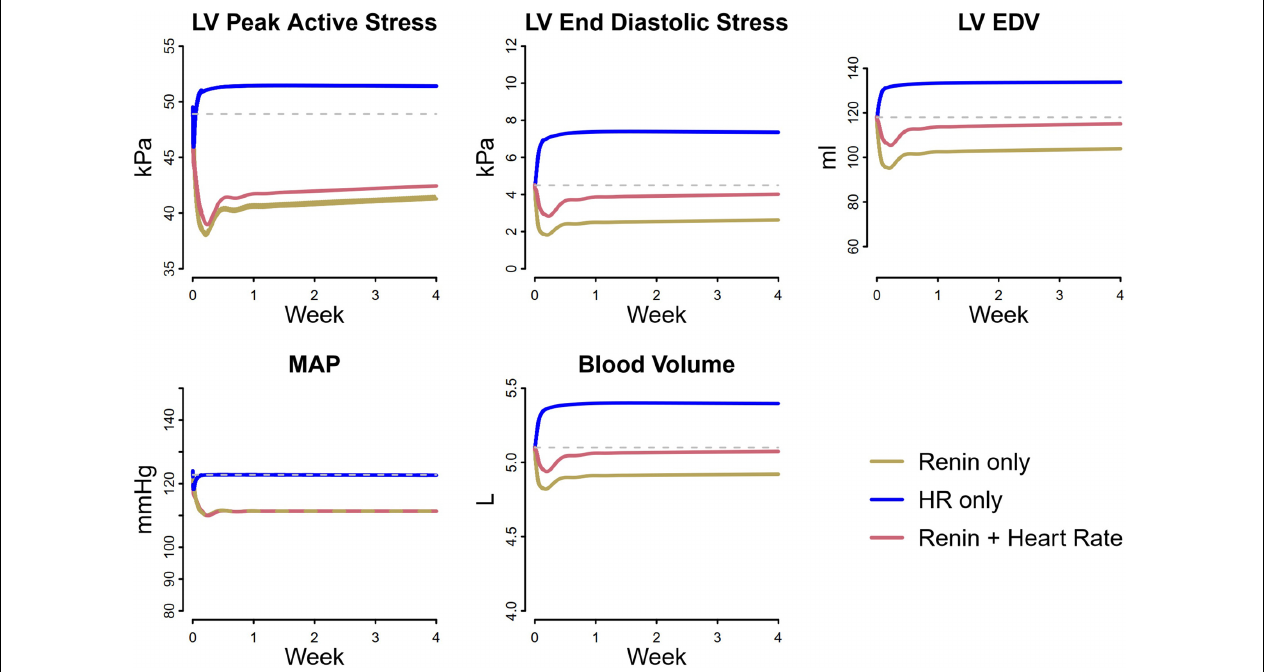
FIGURE 7 | Differential analysis of pathways affected by losartan and atenolol on cardiovascular biomarkers. Renin suppression lowers LV peak active stress, end diastolic stress, and end diastolic volume, due to decreased MAP and blood volume. In contrast, heart rate initially decreases LV peak active stress and MAP, but causes an increase in blood volume, returning MAP to its original value and increasing LV peak active stress, end diastolic stress, and end diastolic volume. When heart rate lowering is combined with renin suppression, the resulting reduction in LV stresses is less than with renin suppression alone, even though the blood pressure reduction is the